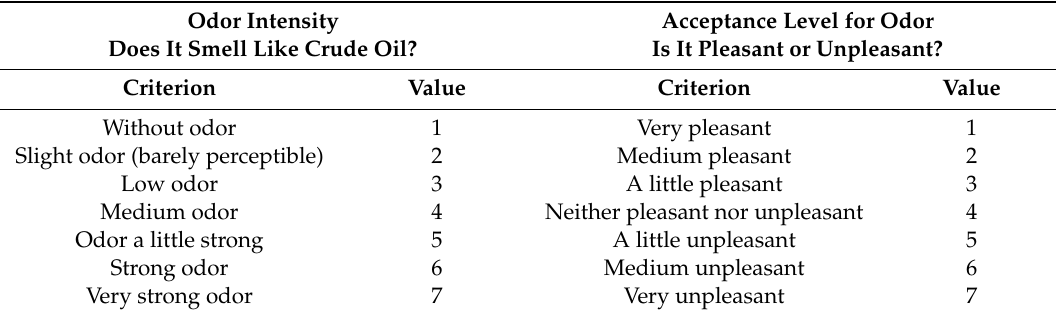
Table 2. Criteria and values for odor